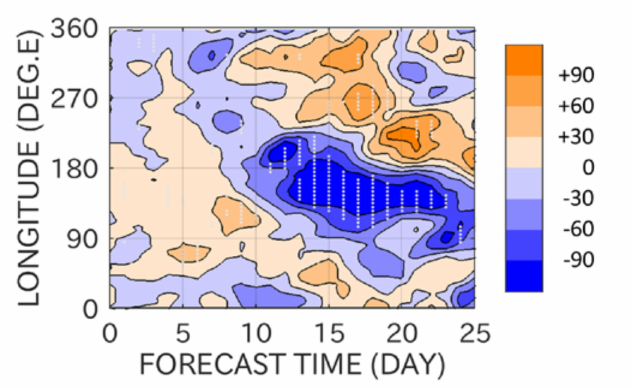
Figure 13. Same as Figure 8, but using the J11 initialization for the second